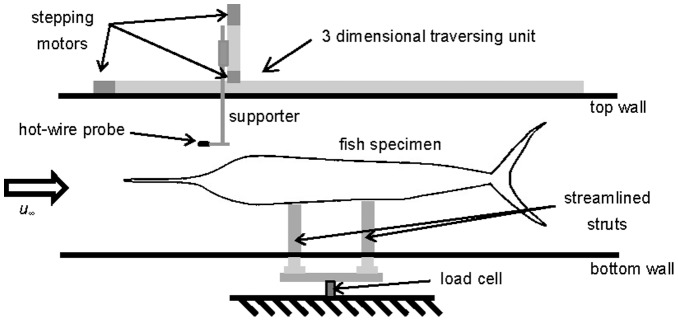
Schematic diagram of the experimental setup.